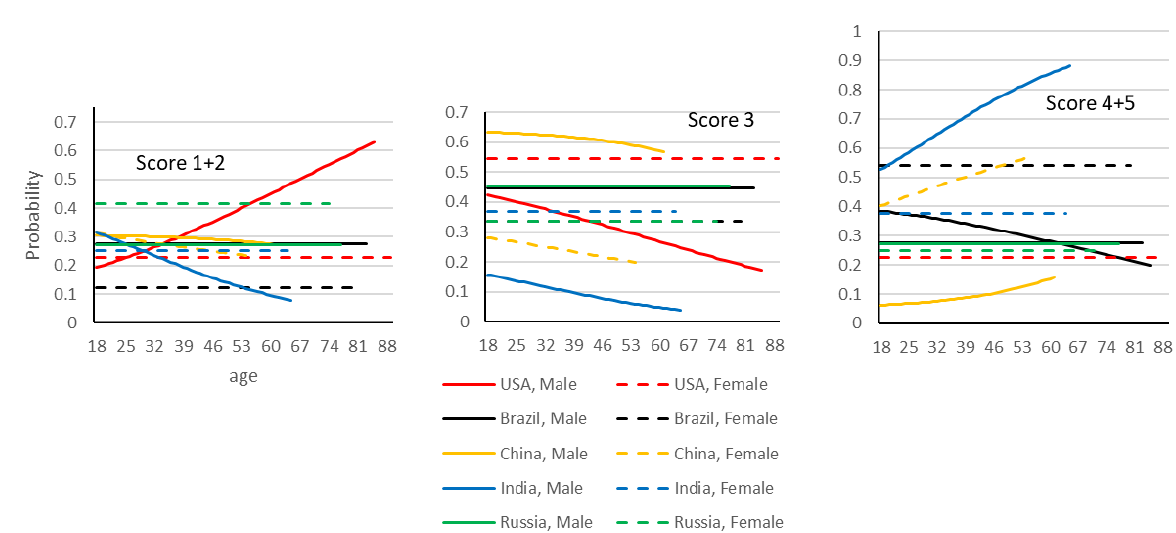
Figure 5. Graphical representation of the multinomial logistic model fitted to the data. The scores 1, 2 and 4, 5 are aggregated. Probabilities associated with disagreement scores (1 + 2), neither agree nor disagree score (3), and agreement scores (4 + 5) given to the statement “ eating meat directly contributes to the suffering of animals ”.